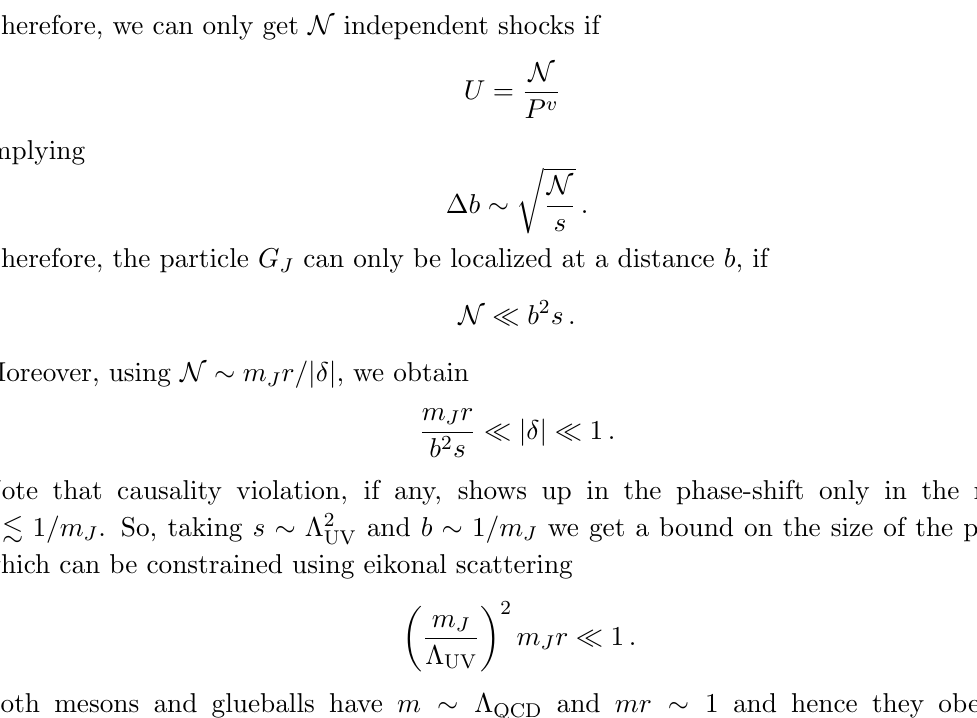
Figure 5 . Total time delay for a coherent state of incoming particles after crossing shockwaves can be large enough to violate asymptotic